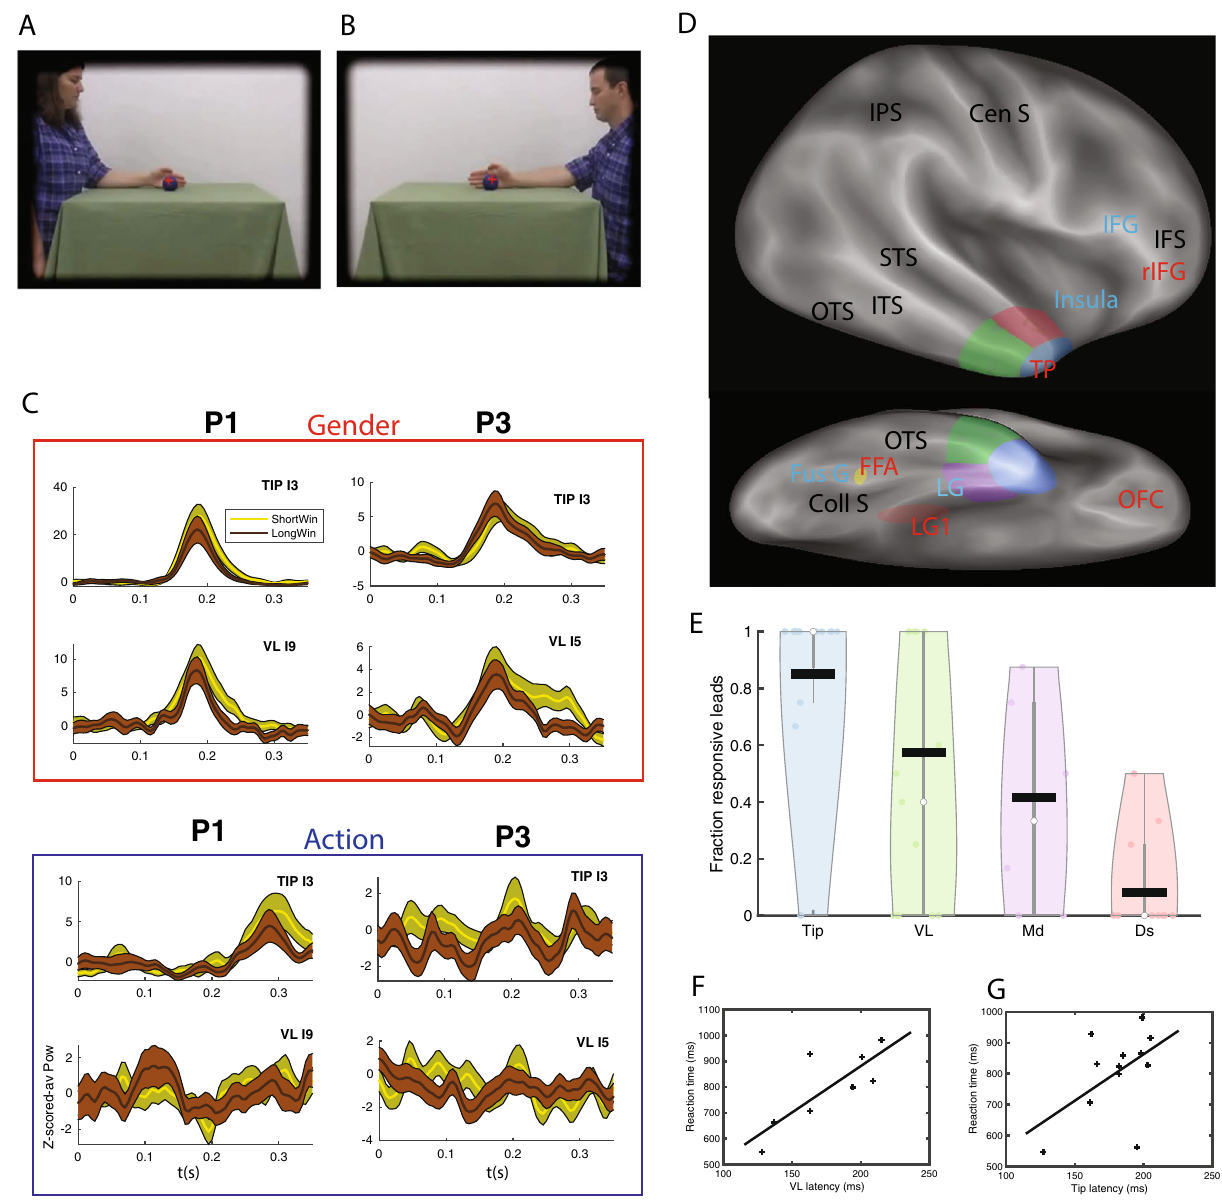
Figure 1. Functional heterogeneity of the TP. ( A ), ( B ): static frames of the video showing the two actors; ( C ): known properties of TP responses: brief phasic responses (wavelet power in gamma band, the mean across trials is z-scored using the spontaneous activity prior to static onset) in (top panels) gender task are similar for short (yellow) and long (brown) stimuli, which are absent in the (bottom panels) action task. We show time courses of power from static onset for example leads (inset) in T and VL for two patients (P1 and P3). Shaded bands represent standard deviation across twenty bootstraps. ( D ): Lateral and ventral views of the unfolded right hemisphere indicating the four parts of TP: dorsal (Ds, red), ventrolateral (VL, green), medial (Md, purple) and tip (T, blue): border between ventrolateral and dorsal or medial in the depth of the STS and OTS respectively; border between ventrolateral and tip at the end of the OTS and STS; the areas that provide the strongest input to TP for the task are labeled in red, these are LG1 (red ellipse), FFA (yellow ellipse), OFC and rIFG. ( E ): proportion of responsive leads in the four subregions: mean: horizontal line, median open circle, dots individual patients; ( F ), ( G ): Reaction time (RT) as a function of latency (‘lat’) of leads in VL (F, 8 patients) and Tip (G, 12 patients); Linear fit: RT: 3.6 lat + 161 ms (F) and RT = 3lat + 263 ms (G) but correlation significant in F (r = 0.80, p < 0.02) and not in G (r = 0.51, p > 0.05). STS superior temporal sulcus, ITS inferior temporal sulcus, OTS occipito-temporal sulcus, Coll S collateral sulcus, IPS intraparietal sulcus, Cen S central sulcus, IFS inferior frontal sulcus, FG fusiform gyrus, LG lingual gyrus, IFG inferior frontal gyrus, OFC orbitofrontal cortex, rIFG rostral inferior frontal